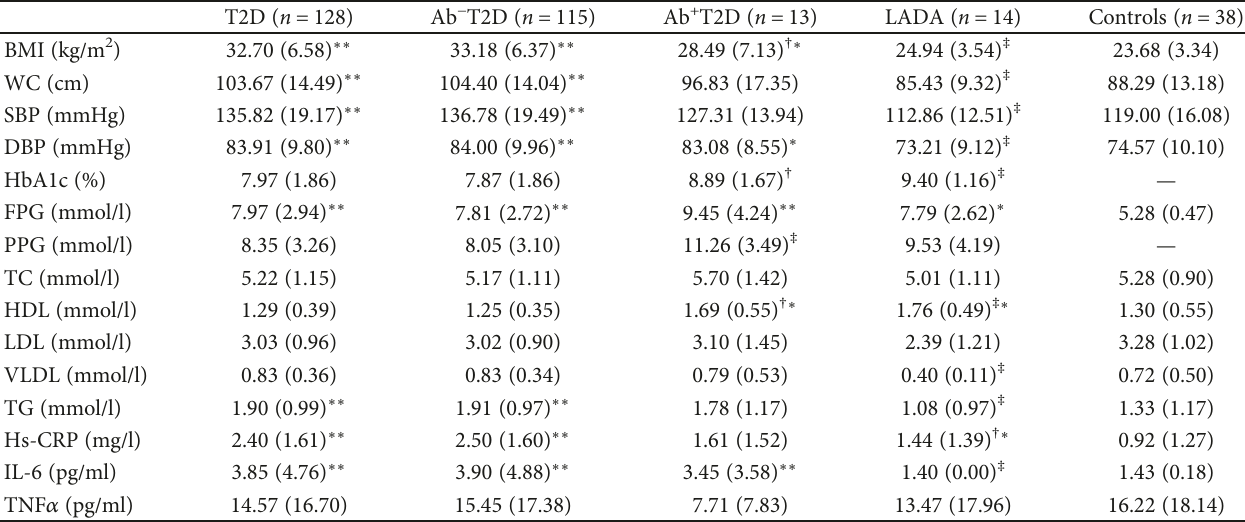
Table 3: Anthropometric data, blood pressure, and metabolic control of subjects.